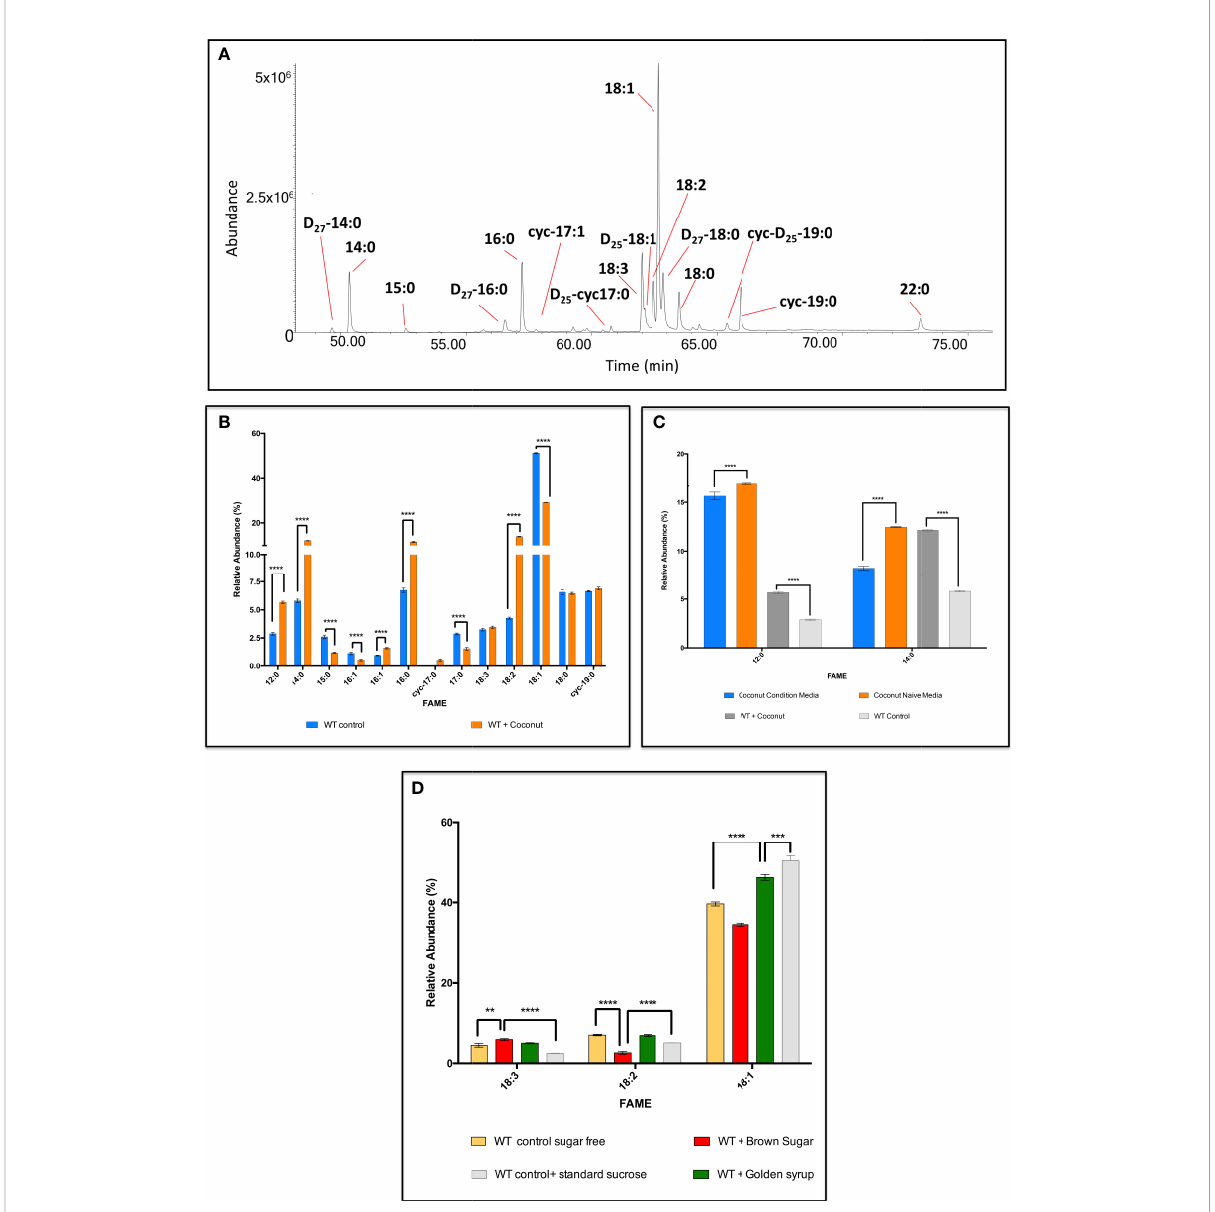
FIGURE 8 GC-MS analysis of the fatty acids synthesised by C. fasiculata WT upon supplementation with various fatty acid and carbohydrate sources. (A) GC-MS chromatogram of the FA pro fi le after internalisation of D 27- myristic acid by C. fasiculata . The cells were supplemented with 50 m M of D 27- myristic acid in minimal media (absence of Tween-80). The parasites showed not only to be able to internalise D 27- myristic acid, but also to use it as alternative building block to produce various deuterated FAs. (B) GC-MS analysis of the fatty acids in C. fasiculata grown in minimal media supplemented with coconut oil. The bar chart shows the FA (X axis) pro fi le and the relative abundance (Y axis) found in C. fasiculata chemically supplemented with coconut oil and the WT control, as shown in the legend. (C) GC-MS analysis of the fatty acids in the naïve and conditioned media from C. fasiculata cells supplemented with coconut oil. The bar chart shows the variation of the relative abundance (Y axis) of 12:0 and 14:0 (X axis) found in the media immediately after supplementation with coconut oil (naïve media), and after 48 h incubation (condition media). Relative abundances of 12:0 and 14:0 are also reported for WT control and WT supplemented with coconut media to highlight their level of internalisation and consumption. (D) GC-MS analysis of the fatty acids in C. fasiculata grown in minimal media supplemented with brown sugar and golden syrup. The bar chart shows 18C UFAs (X axis, the order follows increasing retention time) and their relative abundance (Y axis) found in C. fasiculata chemically supplemented with brown sugar and golden syrup and compared to WT control grown in sugar-free media or with standard sucrose, as shown in the legend. Values are the mean of three independent biological replicates (n=3). Error bars represent the standard deviation of each mean (±). All FAs were identi fi ed using GC-MS based upon retention time, fragmentation, and comparison with standards. Statistical analysis was performed by PRISIM 6 by using One-way ANOVA multiple comparisons based on a Tukey t-test with a 95% con fi dence interval. **** is p ≤ 0.0001, *** is p ≤ 0.001, ** is p ≤ 0.01 and * is p ≤